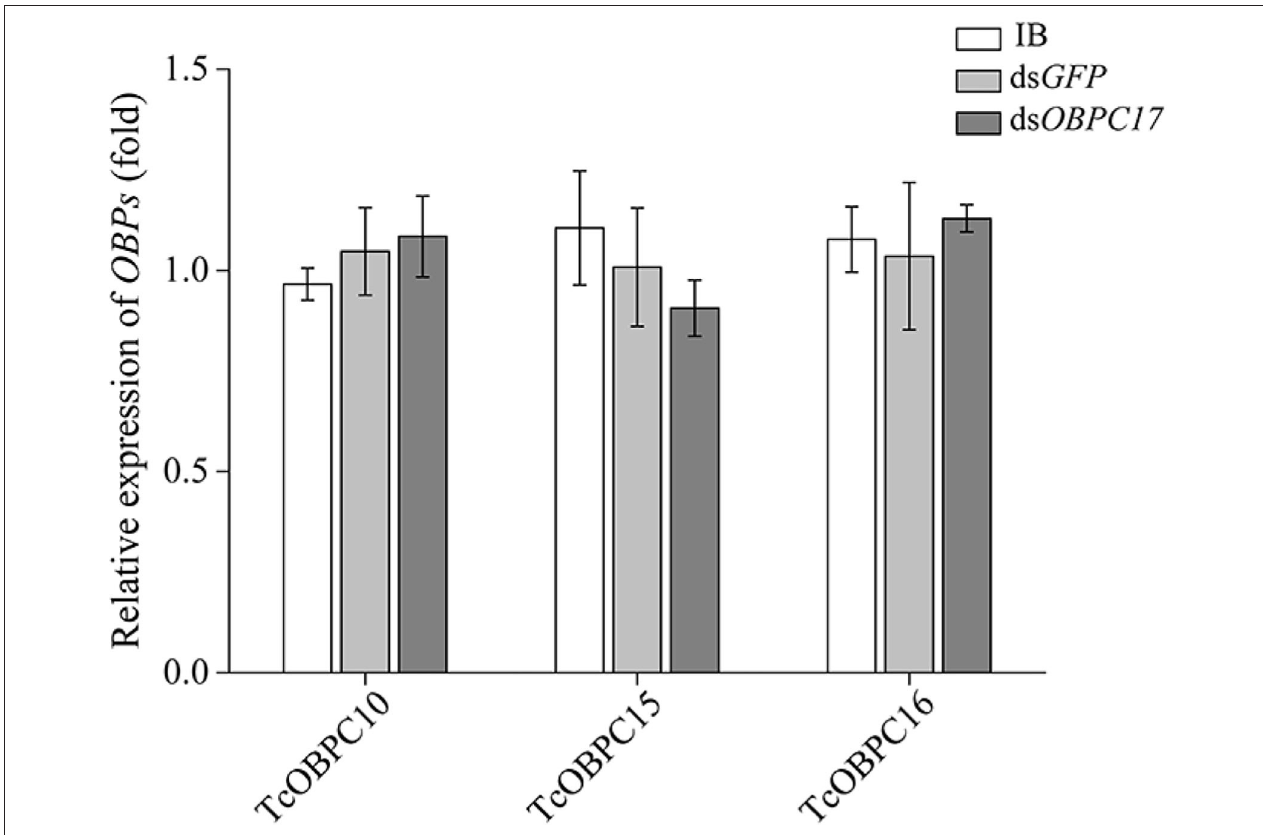
FIGURE 5 | Relative expression of TcOBPC10 , TcOBPC15 , and TcOBPC16 mRNA in T. castaneum 5 days after injection with dsOBPC17. The larvae injected with the equal volume of water (IB) or dsGFP served as the controls. The data are presented as means ± SE ( n = 3). Fisher’s LSD test was employed to analyze the significant difference between the